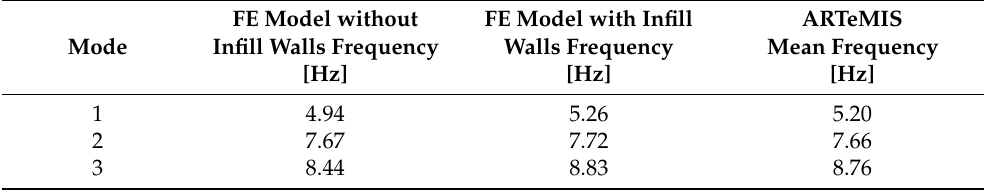
Figure 19. 3D view of the FE model of the “Municipal Headquarters” of Palagianello with infill walls defined by means of SAP2000. Table 4. Comparison between the identified frequency values for different set-up configurations.